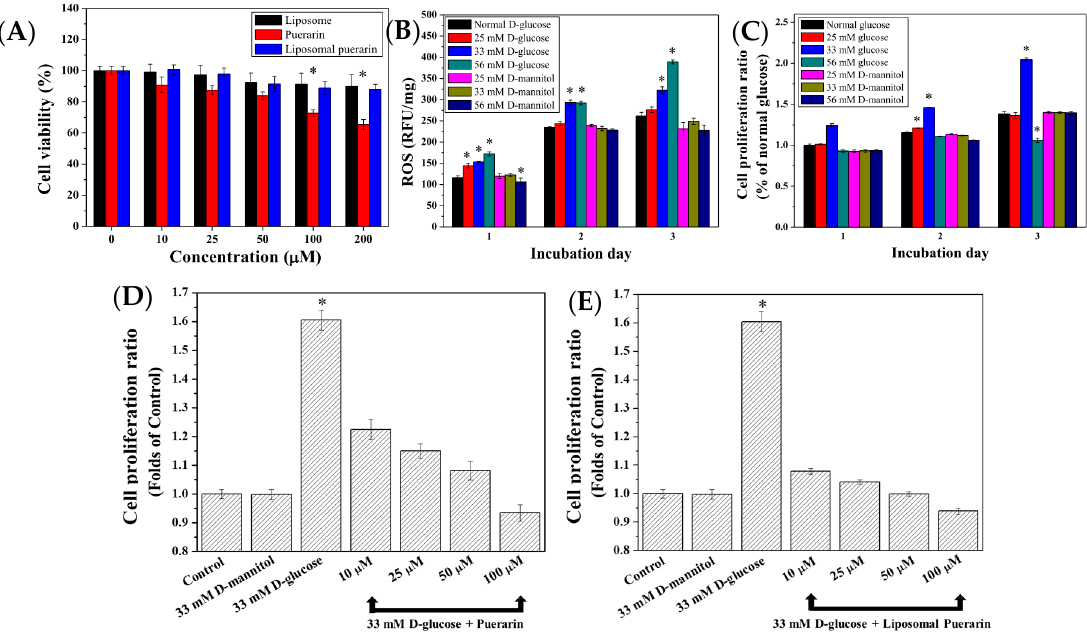
Figure 5. ( A ) Cell viability assay of empty liposome, puerarin extract and liposomal puerarin at various concentrations; ( B ) intracellular ROS of RMCs with respect to different glucose concentrations; ( C ) effects of glucose concentrations on proliferation of RMCs; ( D , E ) cytoprotective effect of puerarin extract and liposomal puerarin on RMCs in high glucose (33 mM). * p < 0.05. The ratios in Figure 5 ( C – E ) were calculated by normalizing with the control (RMCs in 5.6 mM of glucose).